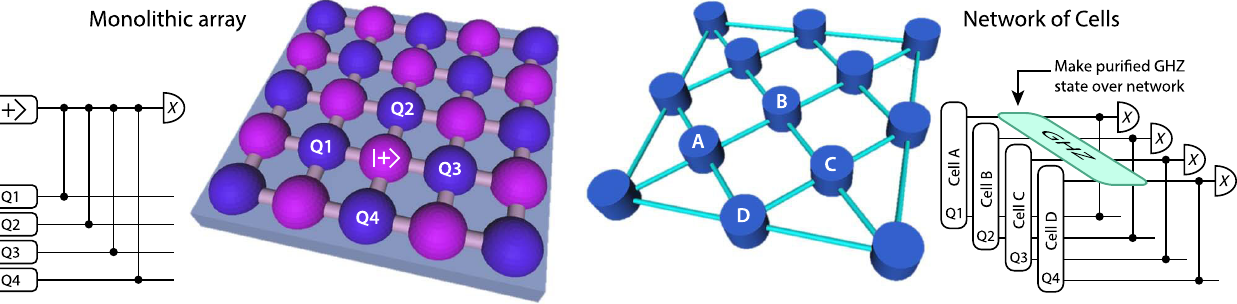
FIG. 2. Monolithic versus network quantum computing. A piece of surface code is represented in the monolithic picture on the left, and in a network architecture on the right. (Here, for clarity we depict a 2D planar code; our network simulations will actually employ the toric code, i.e., periodic boundaries. These two variants are very similar; see Appendix B.) In a monolithic structure [24,25], all qubits are contained within one physical system and two-qubit gates are performed directly between qubits via some physical interaction. In the network picture, the system is instead divided up into small cells, each of which contains a modest number of qubits that interact directly, while between cells only noisy and lossy interactions are possible. For the monolithic system, stabilizer measurements are performed by using a dedicated set of ancilla qubits (pink) interlaced with the data qubits (blue). In contrast, an efficient route to making stabilizer measurements in the network model is to first purify a shared GHZ state between the cells involved and then use this resource to evaluate the stabilizer: The parity of the four qubits measured out from the GHZ tells us the stabilizer outcome. In subsequent cycles, cells are grouped into different sets of four in order to evaluate a complementary set of stabilizers; see